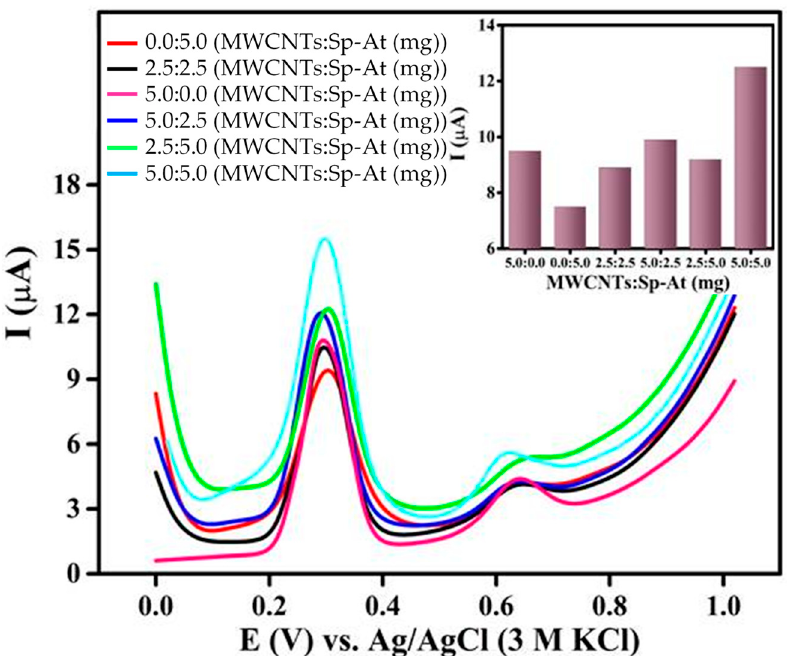
Figure 3. Effect of the MWCNTs/Sp-At ratio on GA oxidation (DPVs recorded in 0.1 M phosphate buffer, pH 4, containing 30 µ M GA at a scan rate of 0.1 V · s − 1 ). Inset: bar graphs corresponding to each electrode current response.